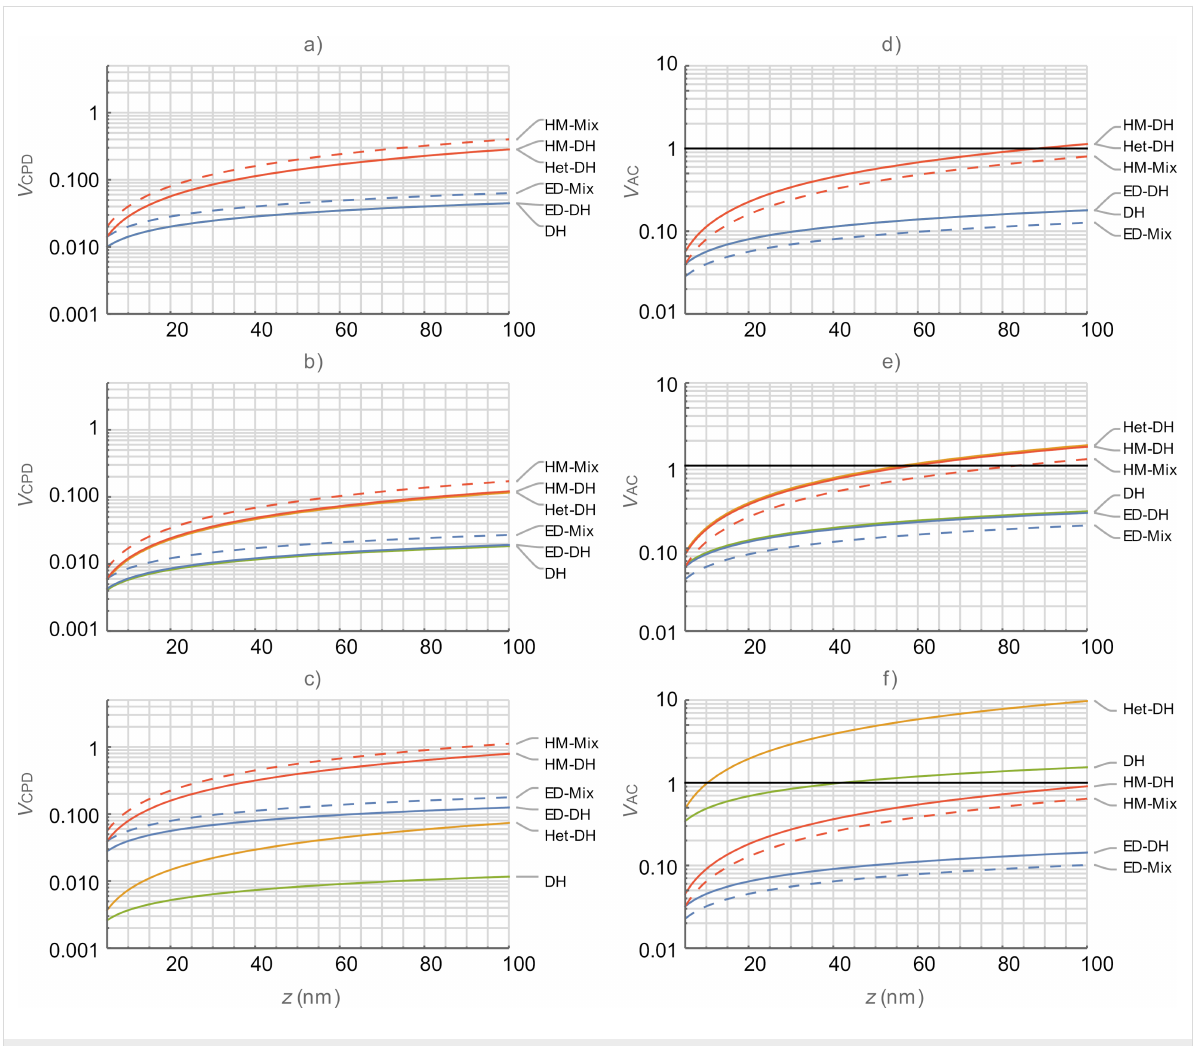
Figure 4: Comparison between OL KPFM modes in water as a function of the tip–sample separation, z . (a–c) and (d–f) for the first harmonic electrostatic response occurring on ω off (top), ω 1 (middle), and ω 2 (bottom), respectively. DH (green), Het-DH (orange), ED (blue), and HM (red). The black lines in (d–f) indicate = 1.0 V. Mixed responses are shown with dashed lines. Lower bias is better for all